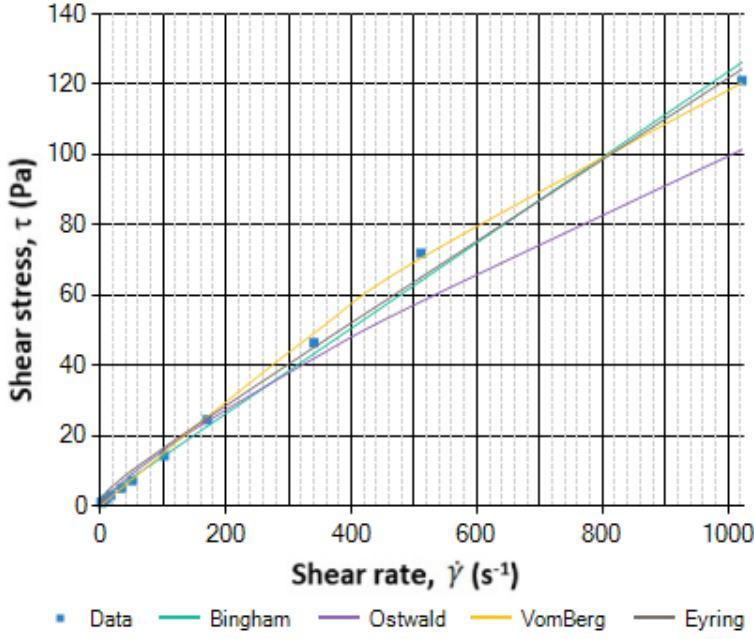
Figure 7. Comparison of the selected rheological models, cement w / c 0.5.